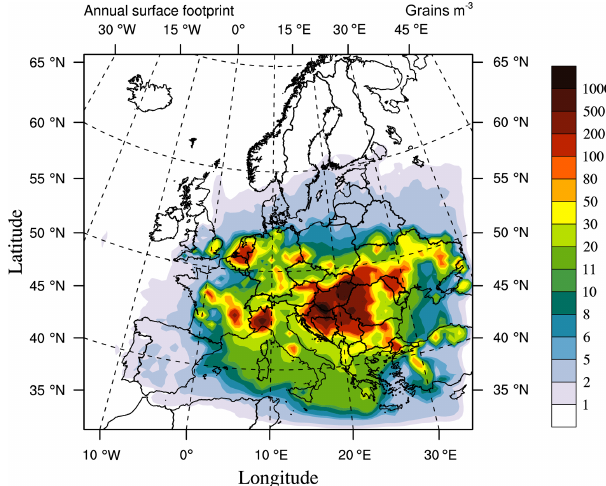
Figure 9. Annual footprint of ragweed pollen at the surface, ob- tained by selecting the maximum from daily averaged concentra- tions during the whole pollen